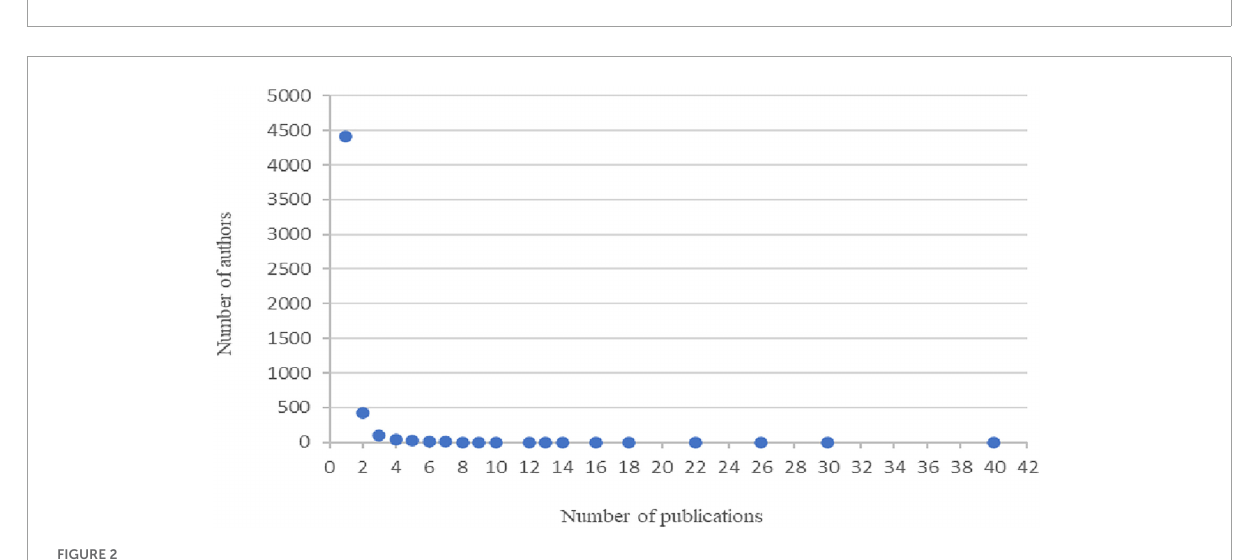
FIGURE1 Number of documents published per year.